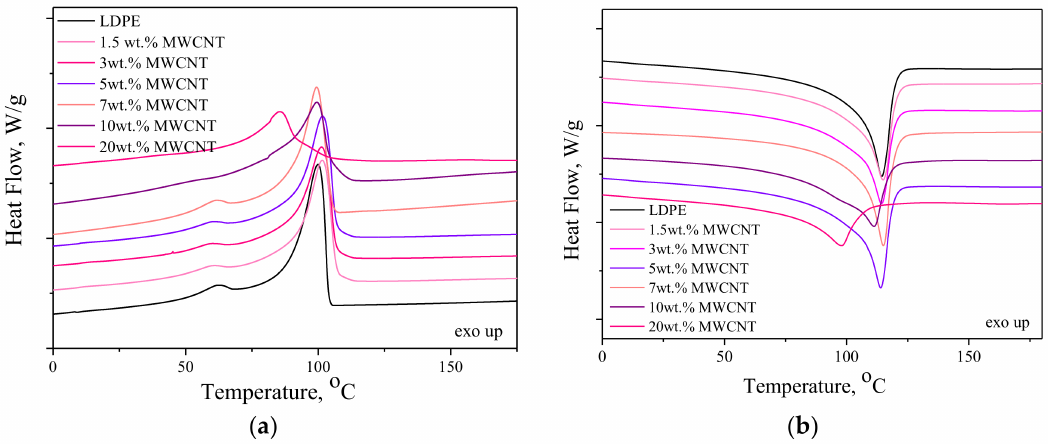
Figure 4. Differential scanning calorimetry (DSC) thermograms for LDPE/MWCNT nanocomposites recorded during cooling ( a ) and second heating ( b